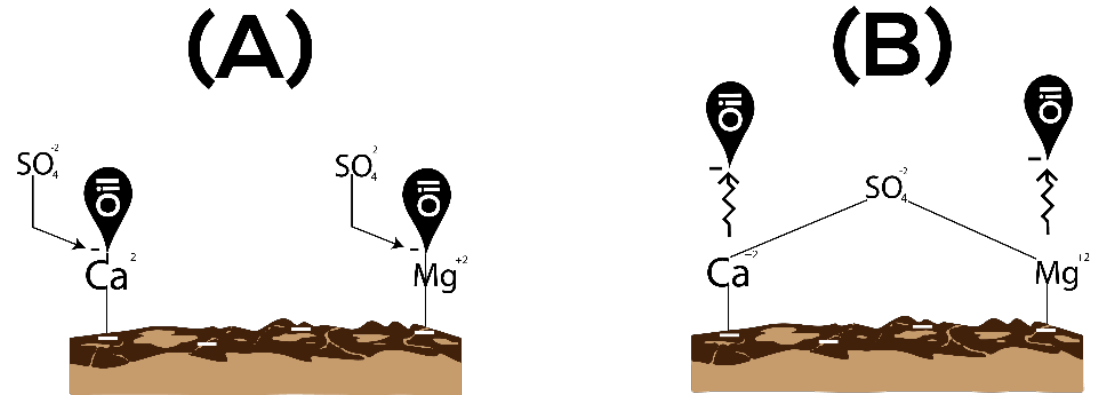
Figure 1. Wettability alteration mechanism of sulfate in sandstone. ( A ) refers to oil-wet; ( B ) refers to water-wet condition of reservoir